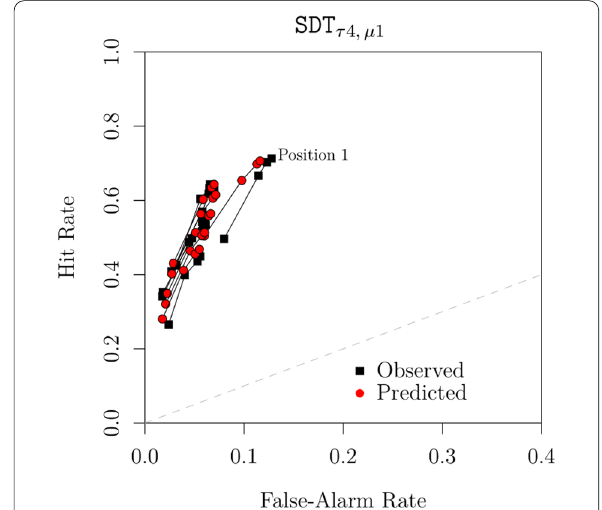
Fig. 14 Observed confidence rating ROCs and the corresponding predictions from SDT τ 4, µ 1 (Reanalysis of Dunn et al.,